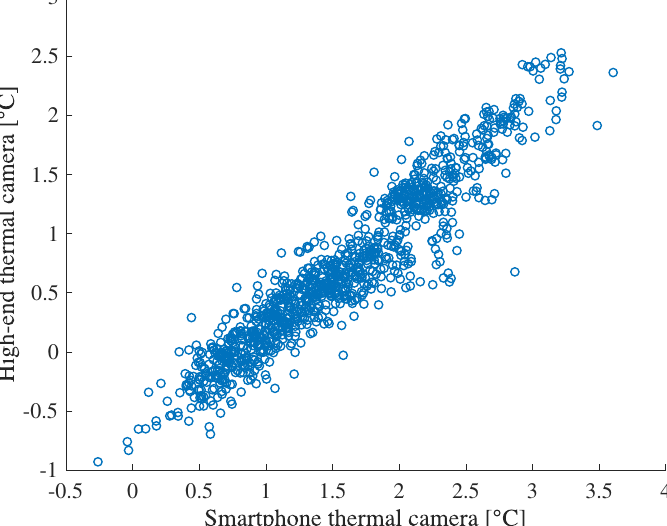
Figure 8. Relation between temperature differences (face–wrist) measured by a high-end thermal camera and smartphone thermal camera.